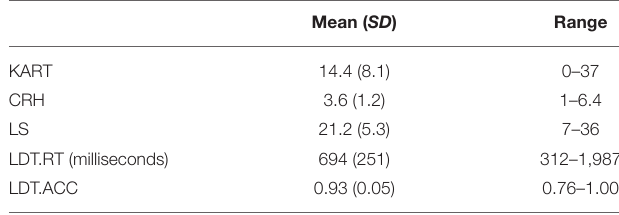
TABLE 1 | Means, standard deviations, and ranges of each